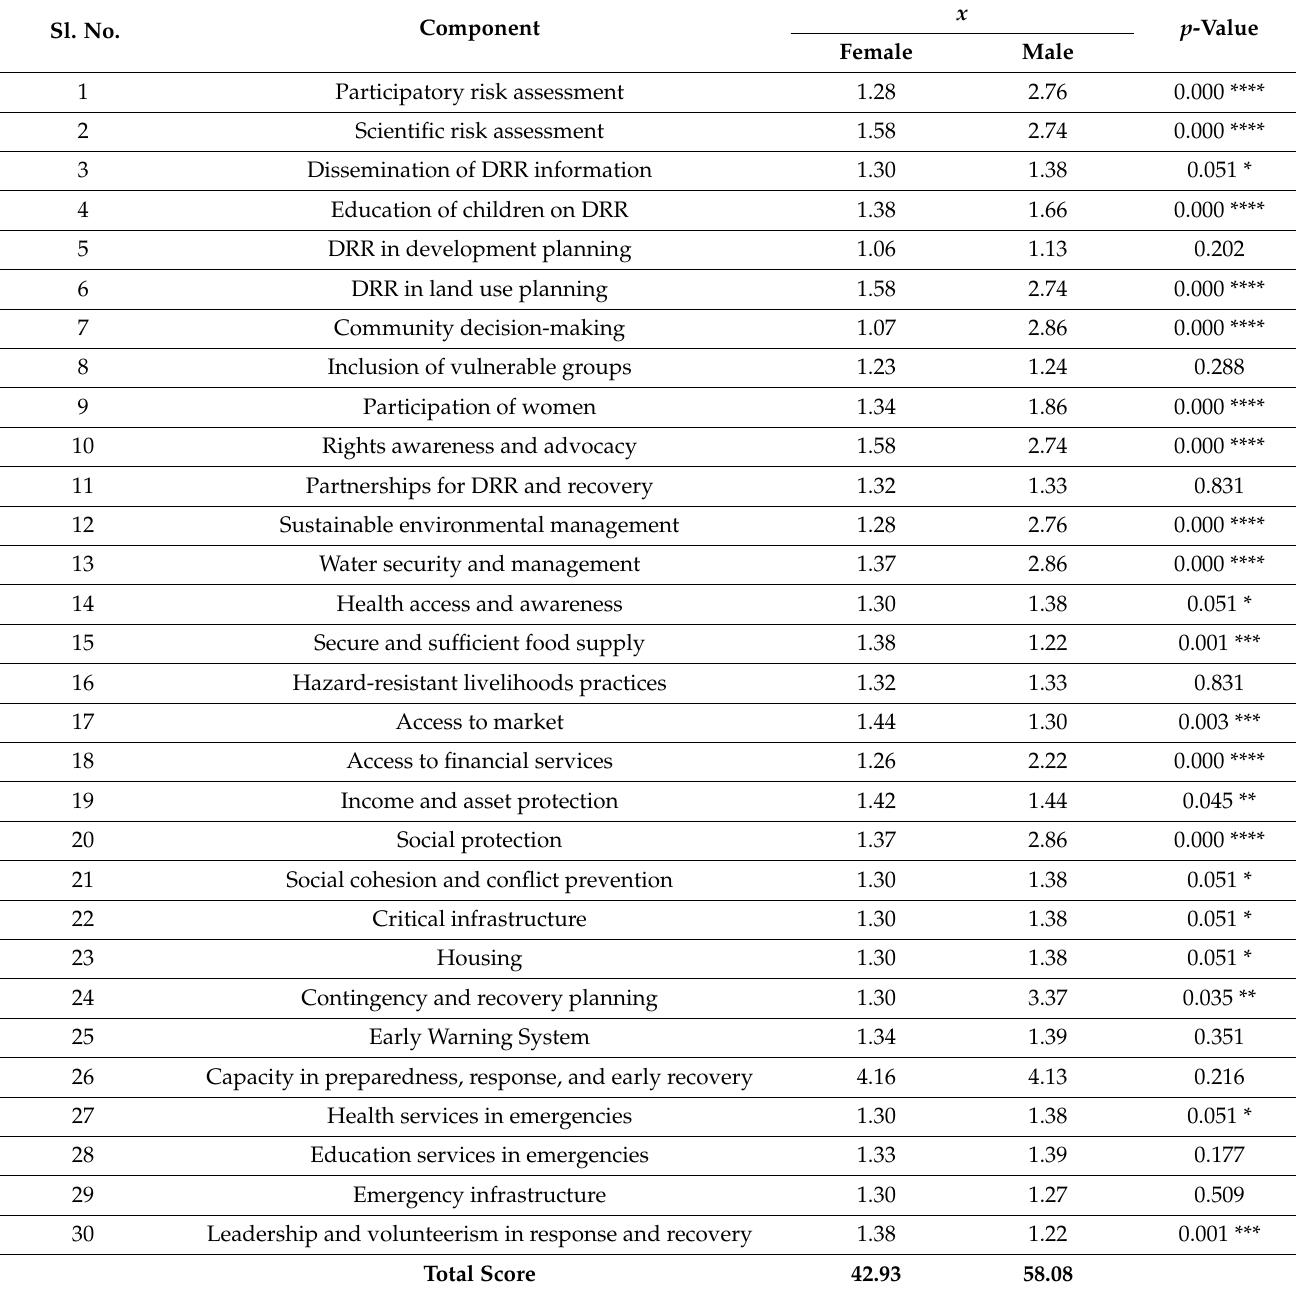
Table 4. Community resilience level